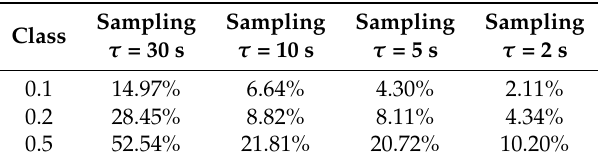
Table 3. Maximal relative error of the line temperature estimation method for a complete set of noise-containing data.